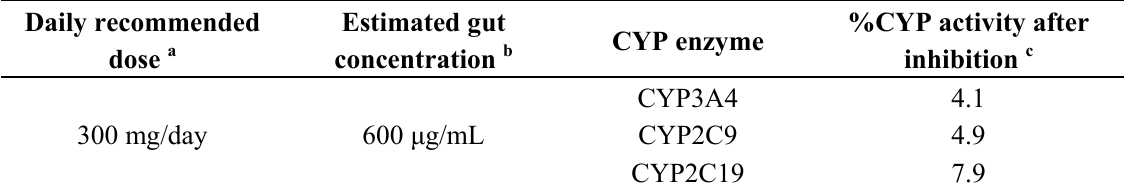
Table 2. Suppression of intestinal CYP450 activities by recommended oral dose of B. monnieri extract (300 mg/day). The projected % CYP450 activity values were calculated based on the theoretical model proposed by Fotti et al. (2007). dose a